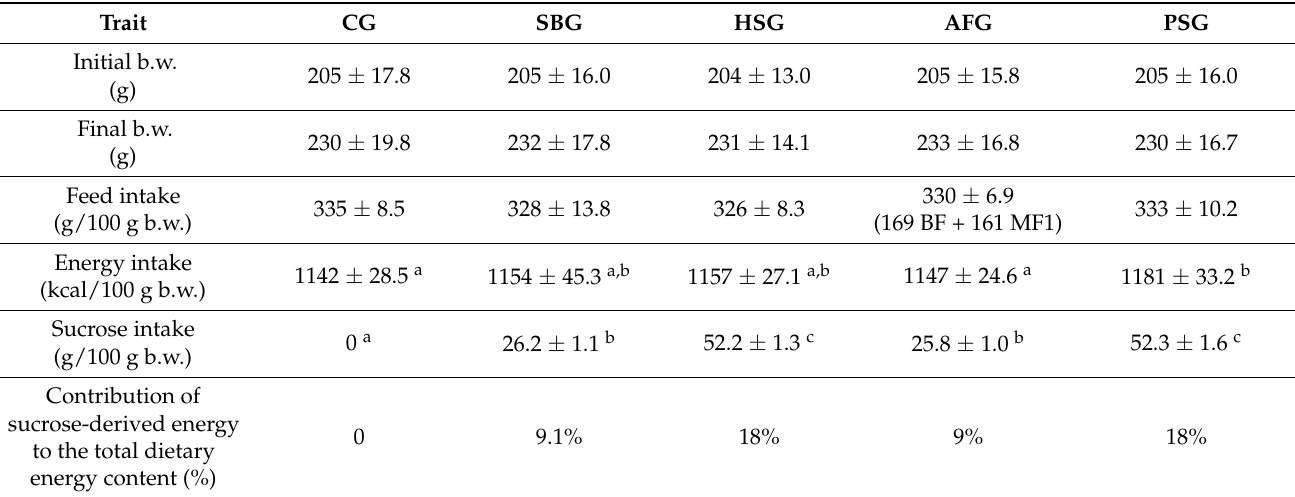
Table 1. Body weights, feed, energy, and sucrose consumption of the tested animals.